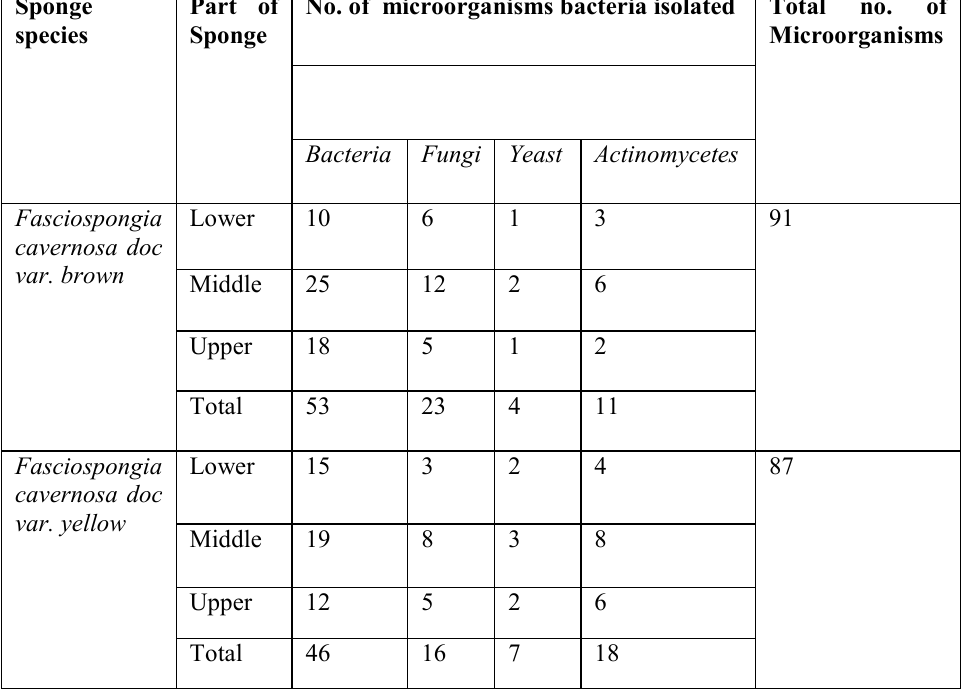
Table 1. Microorganisms isolated from various parts of the